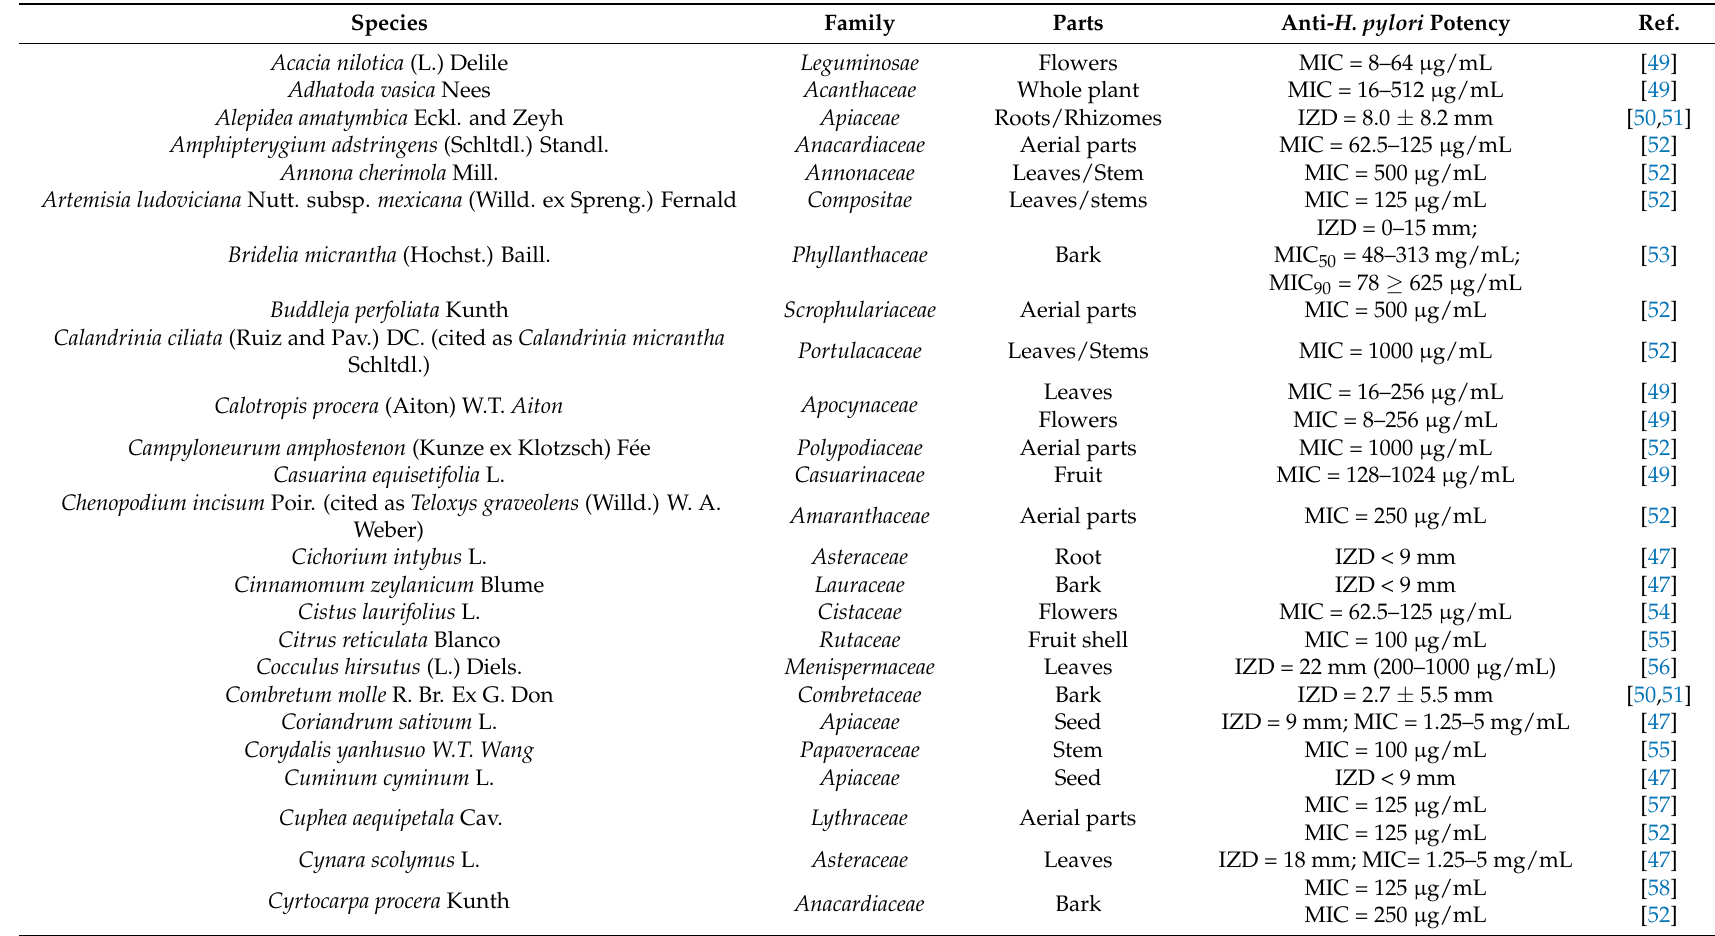
Table 1. Plant aqueous extracts with anti- Helicobacter pylori